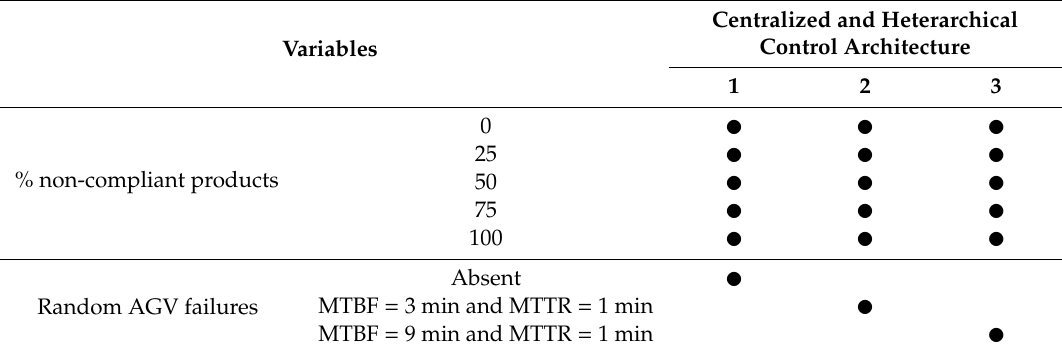
Table 4. EDF simulation model